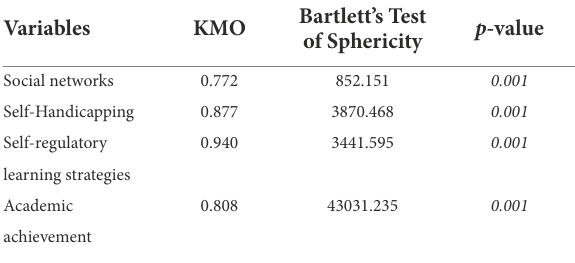
TABLE 1 KMO and bartlett test to evaluate the adequacy of sampling and data correlation.